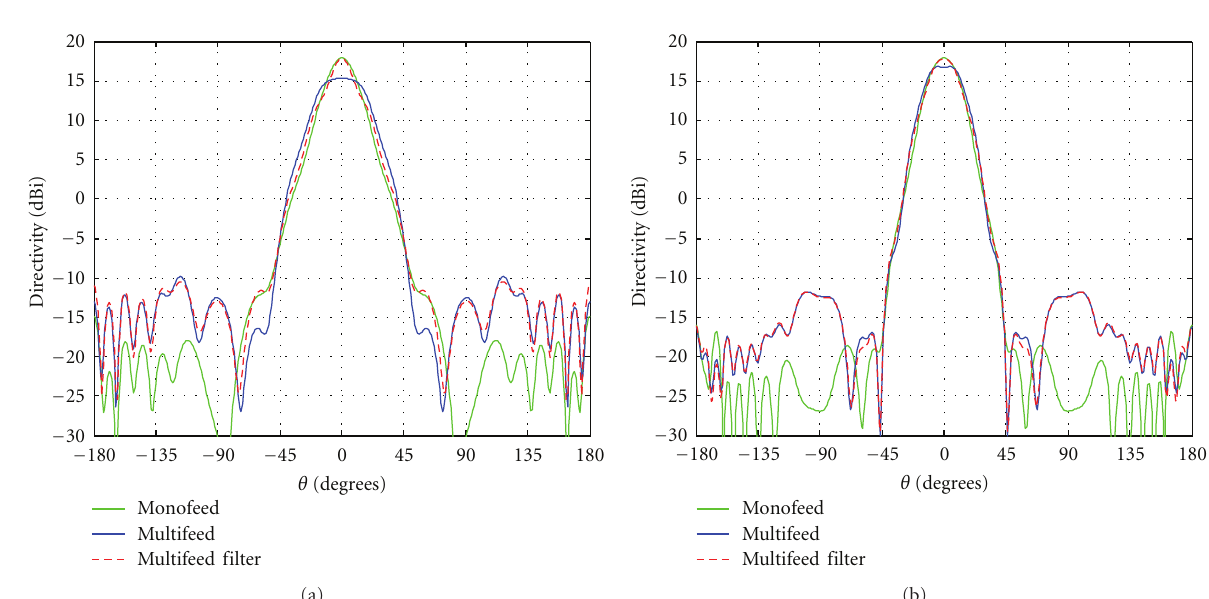
Figure 21: Radiation pattern of the EBG dual-band antenna at f L (a) and f H